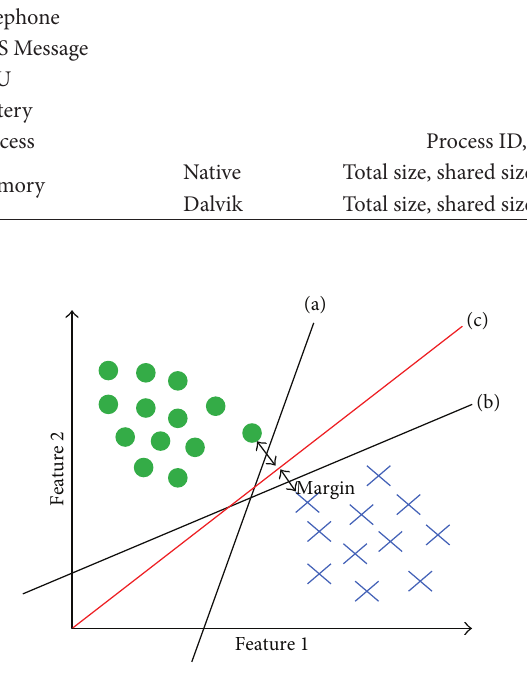
Figure 2: Data classification method of